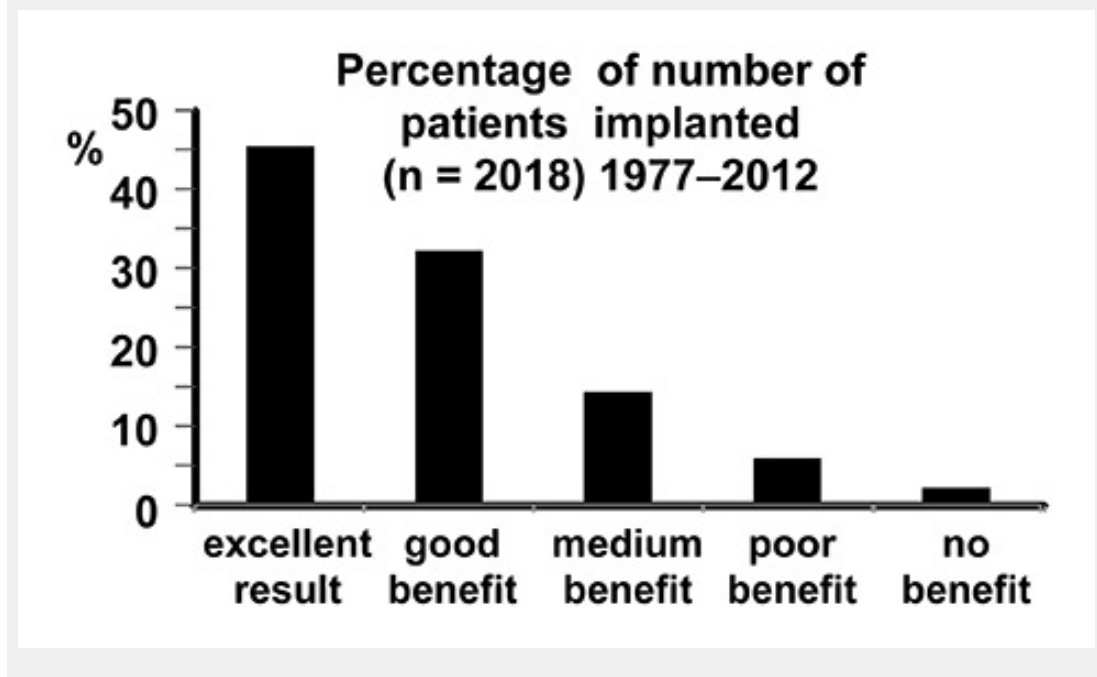
Figure 4 Subjective benefits of cochlear implant users implanted until 2012 in Switzerland. Patients with first generation single channel implants as well as patients with implant use shorter than 6 months were excluded from this summary. Patients were asked to describe their benefit on a five- point scale from “no benefit” to “excellent”